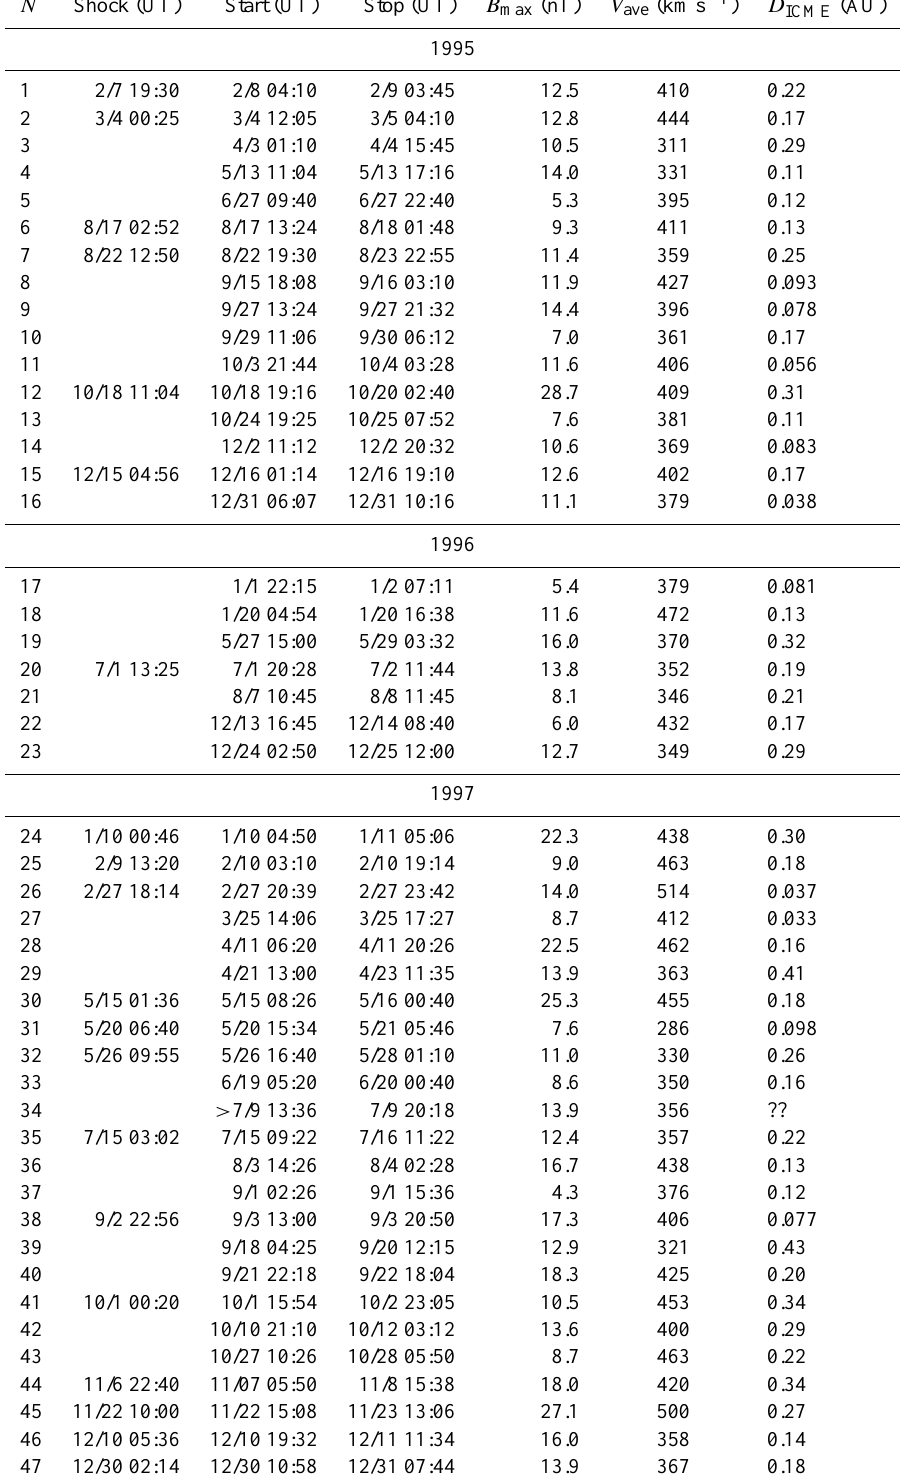
Table 1. ICMEs identified from the OMNI data base from January 1995 to December 1997. The columns show, the event number, time of the interplanetary shock, start and stop times of the ICME interval, maximum magnetic field within the ICME ( B max ), average speed of the ICME ( V ave ), and the average width of the ICME ( D ICME